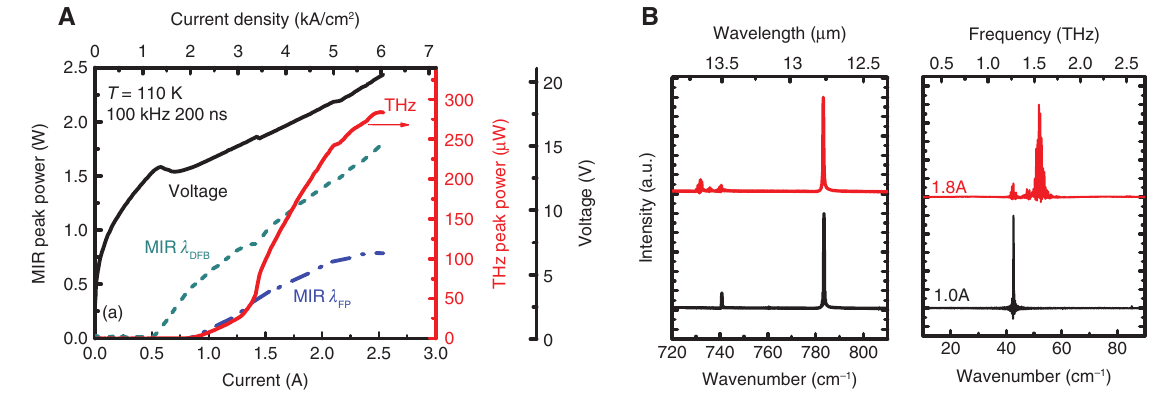
Figure 5: Device performance of the 1.1-THz source at 110 K. (A) Current-voltage-light ( I - V - L ) output characteristics of the MIR (dashed lines, bottom and left axis) and THz emission (solid red line, bottom and right axis) of a 3-mm-long and 14- μ m-wide QCL at 110 K with 200 ns pulsed at 100 kHz. (B) MIR and THz spectra at 110